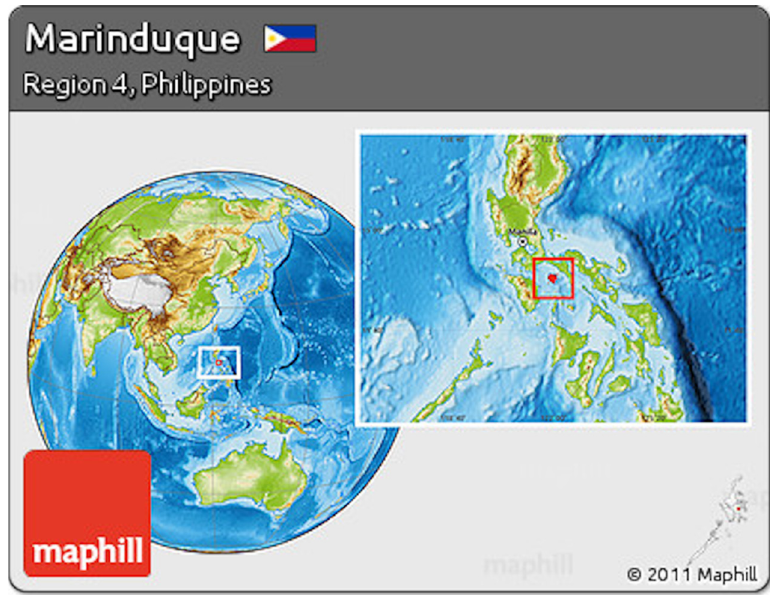
Figure 1. Location map of Marinduque Philippines. Original image from ©Maphill (2011) distributed under license CC BY-ND.